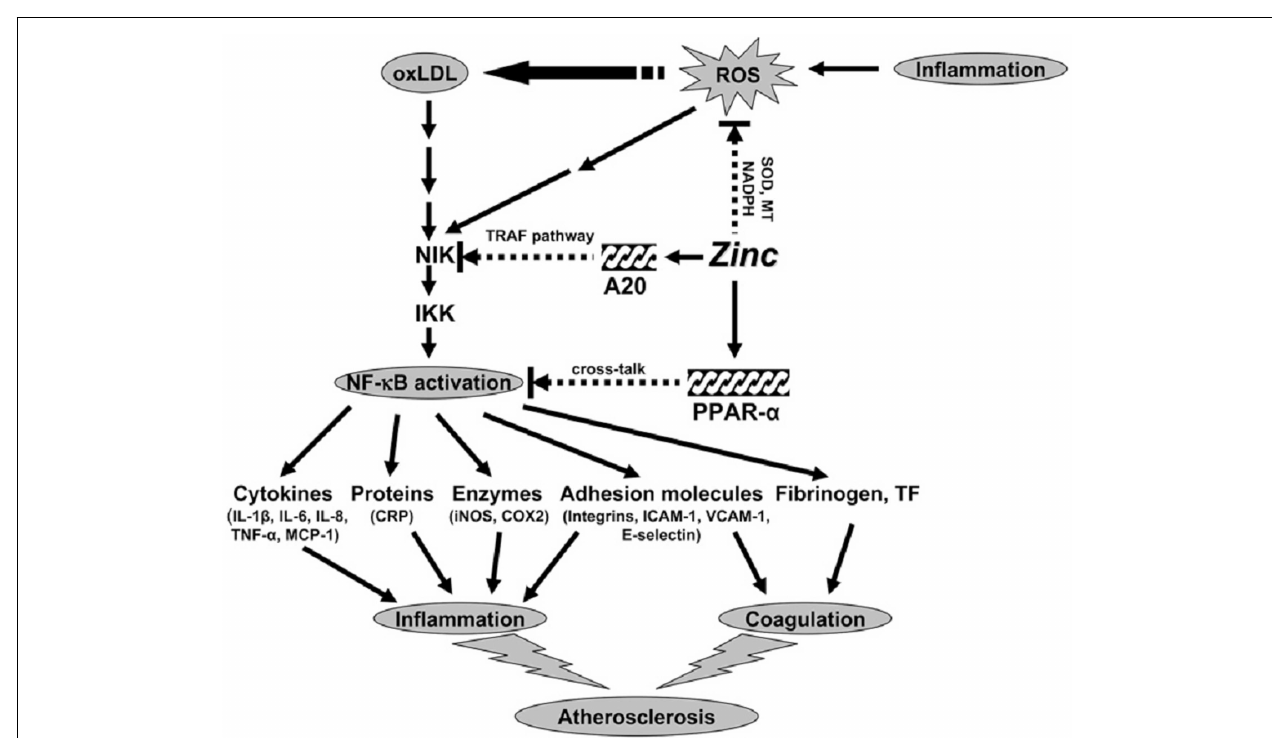
of atherosclerotic cytokines/molecules such as inflammatory cytokines, adhesion molecules, inducible nitric oxide synthase (iNOS), cyclooxygenase 2 (COX2), fibrinogen, and tissue factor (TF) through inhibition of NF- κ B activation by A20-mediating tumor necrosis factor (TNF)-receptor associated factor (TRAF) signaling and peroxisome proliferator-activated receptor a (PPAR-a)-mediating crosstalk signaling.The black arrows indicate up-regulation; arrows with a broken line indicate down-regulation or the inhibitory pathway. IKK, I- κ B kinase; IL, interleukin; MCP-1, macrophage chemoattractant protein 1; CRP, C-reactive protein; ICAM-1, intercell adhesion molecule 1;VCAM-1, vascular cell adhesion molecule 1